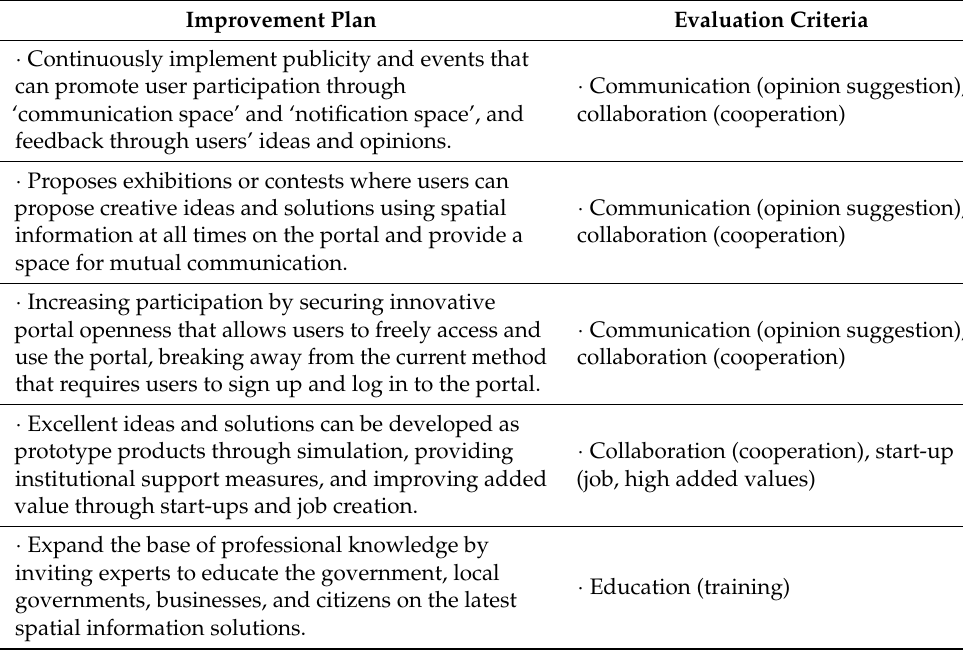
Table 7. Improvement plan of stakeholder